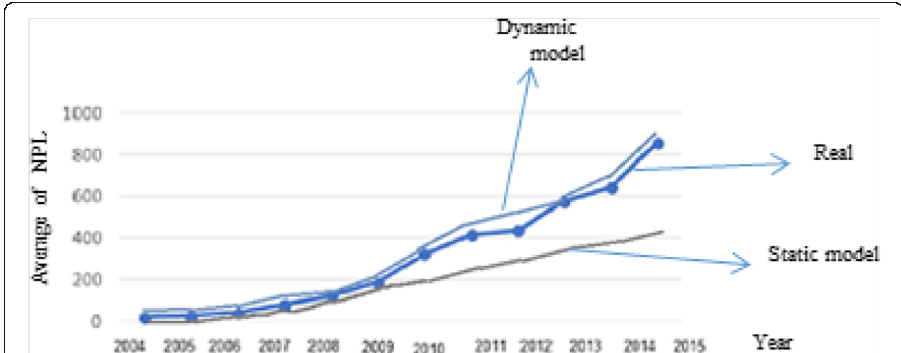
Fig. 22 The comparison between the static model, dynamic model and real. We compared the NPL rate predicted by the static models used by the banks with our proposed dynamic model and there is a significant difference ( p value = 0.006) between the predictions of the two models. This Fig shows the comparison between the prediction of our proposed model and the real NPL. There is a little difference between them according to the proposed model. As an example, the average of NPL has been predicted 200billion Rials more than real NPL in 2012. The light blue line is the NPL according to the dynamic model. The dark blue line is the NPL according to the real and the gray line is the NPL base on the static model